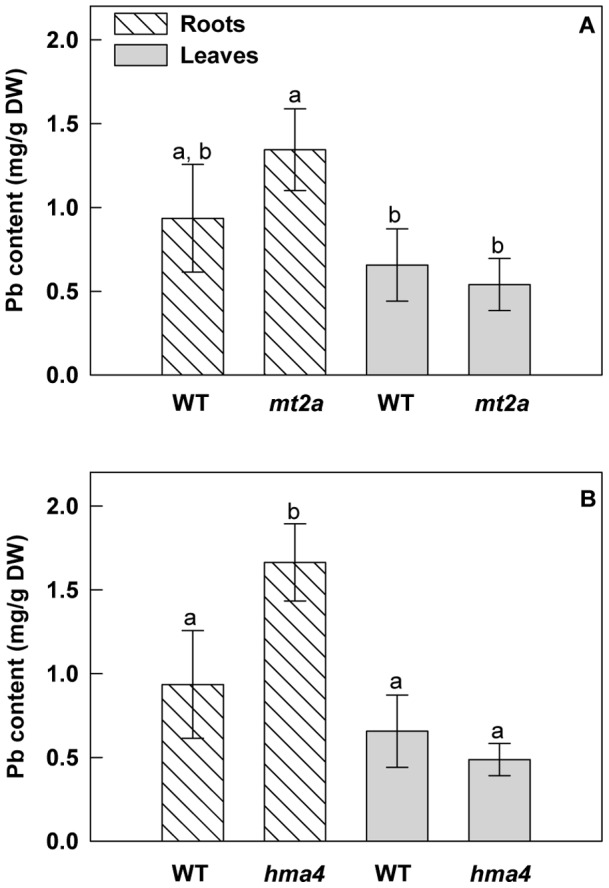
Lead accumulation in roots and shoots of wild-type and knockout mutant seedlings of A. thaliana.Seedlings were collected after 13 days of culture on agar plates with or without 40 µM of Pb(NO3)2. (A) Atmt2a T-DNA mutant analysis. (B) Athma4 T-DNA mutant analysis. All results are the average value (± SE) of three independent replicates. For the roots and leaves separately, the letters represent statistically homogenous subgroups using LSD post hoc test at a α = 0.01 significance level.